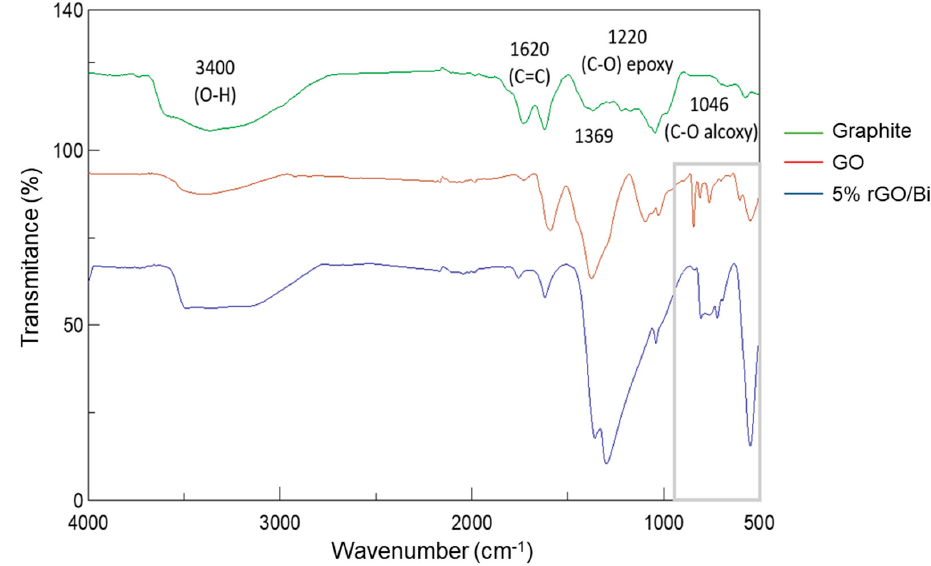
Figure 5. FTIR spectra of graphite, graphene oxide, and 5%rGO / Figure 5 . FTIR spectra of graphite, graphene oxide, and 5%rGO/Bi.